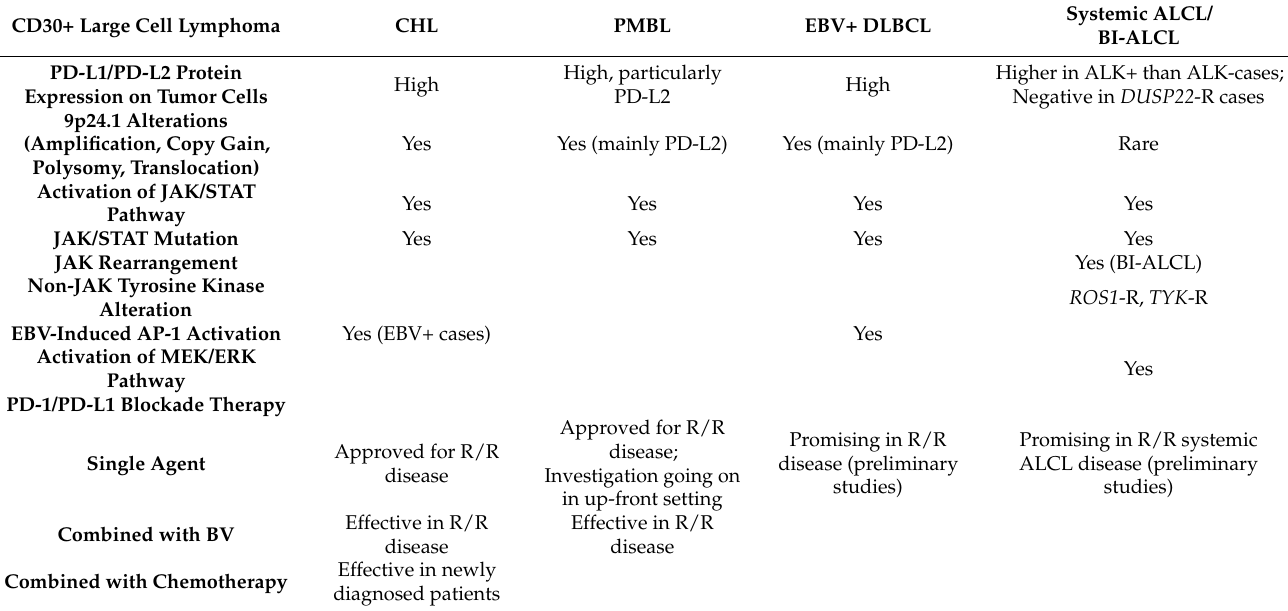
Table 1. PD-1/PD-L1 pathway and its blockade in CD30+ large cell